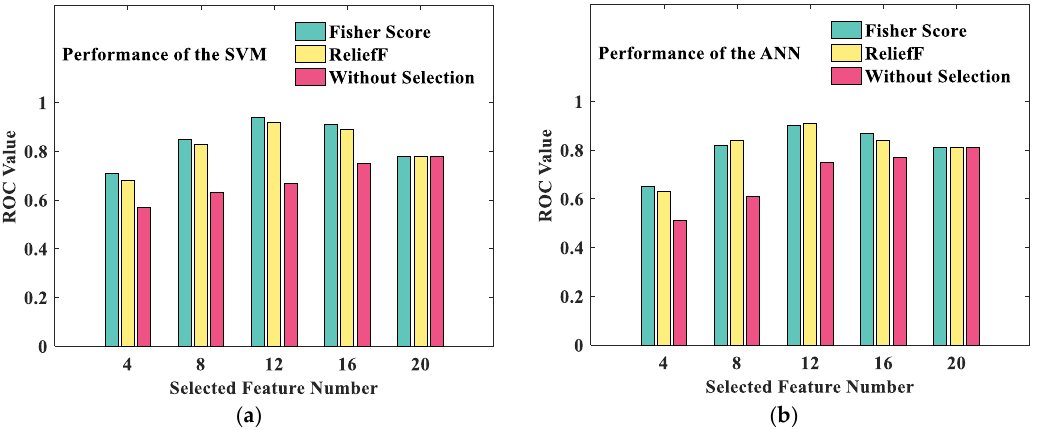
Figure 9. Receiver operating characteristic value by using the SVM and ANN. ( a ) ROC value by SVM training model; ( b ) ROC value by ANN training model.